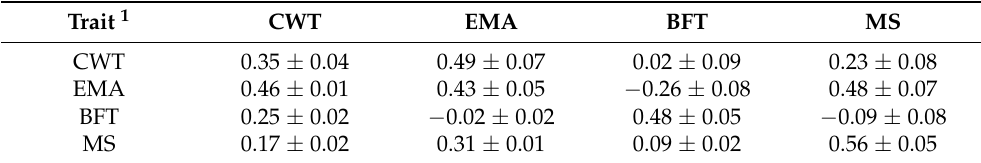
Table 4. Heritability estimates (diagonals), genetic correlation (above diagonals) and phenotypic correlation estimates (below diagonals) among carcass traits of Hanwoo